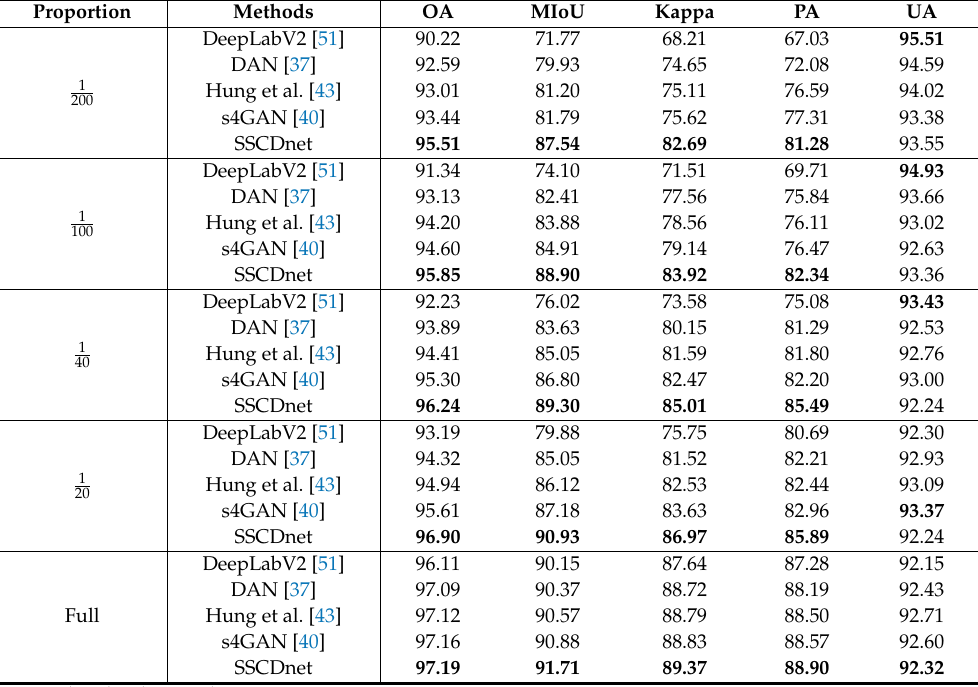
Table 6. Cloud extraction accuracy (%) of different comparison networks on GF-1 WFV data. All results are the averaging results on all testing